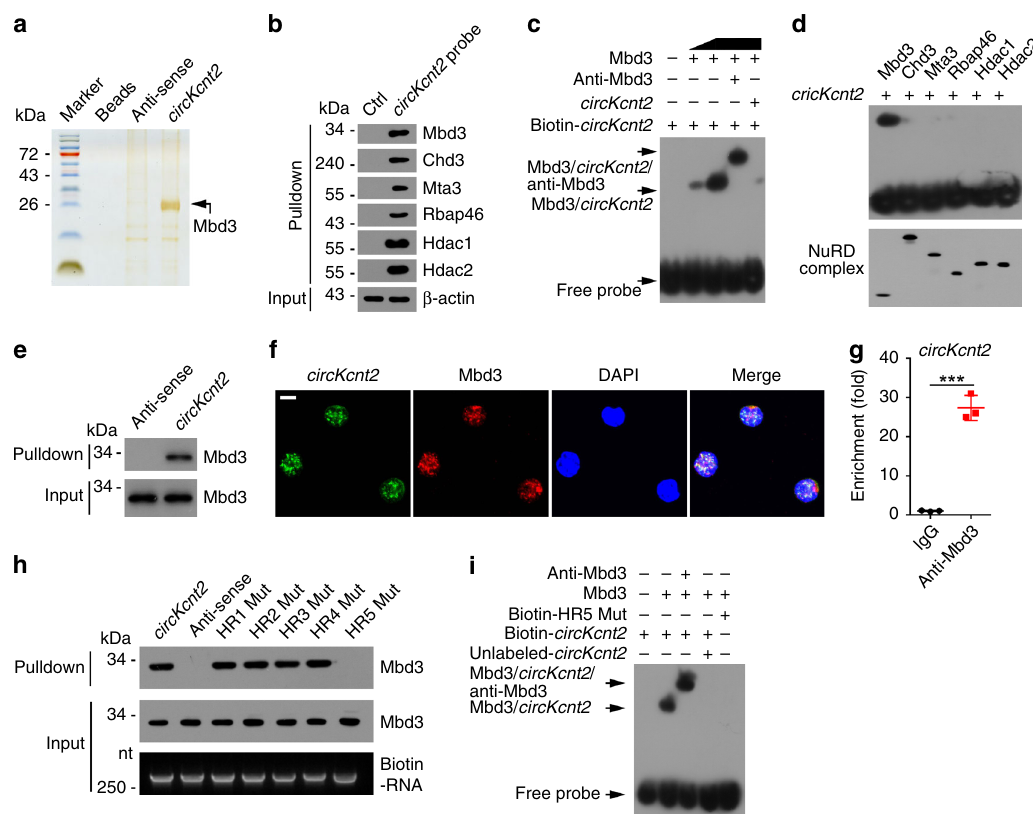
Fig. 4 CircKcnt2 associates with Mbd3. a LPL cells from DSS-treated WT mice were lysed and incubated with biotin-labeled and linearized circKcnt2 transcripts, anti-sense, or Sepharose 4B beads control. Precipitants were resolved by SDS-PAGE, followed by silver staining. Indicated bands were identi fi ed via mass spectrometry. b LPL lysates were incubated with circKcnt2 probes or controls, followed by western blotting using indicated antibodies. c Electrophoretic mobility shift assay (EMSA) using biotin-labeled circKcnt2 and recombinant Mbd3 with or without anti-Mbd3. d EMSA assay using linearized circKcnt2 RNAs and Flag tagged NuRD complex component proteins. e RNA pulldown assay was performed using linearized and biotin-labeled circKcnt2 RNAs or anti-sense through LPL cell lysates. f CircKcnt2 was co-localized with Mbd3 in ILC3s by immuno fl uorescence staining. Scale bar, 5 μ m. g RNA immunoprecipitation (RIP) assay was conducted using anti-Mbd3 or IgG through LPL lysates from DSS-treated mice (*** P = 0.0001). n = 3 independent samples. h RNA pulldown assay was performed using WT circKcnt2 and its different mutations. i EMSA assay using WT circKcnt2 or HR5 mutation. *** P < 0.001. Data were analyzed by an unpaired Student ’ s t -test and shown as means ± SD. Data are representative of at least three independent experiments. Source data are provided as a Source Data fi